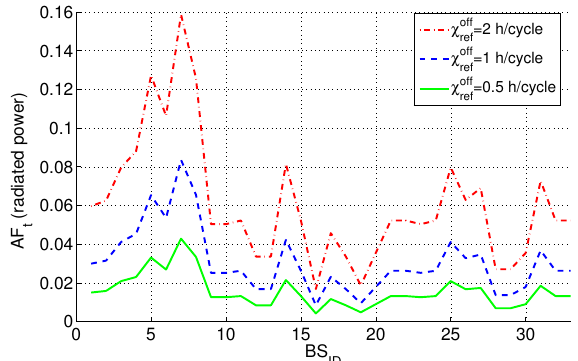
Figure 9. AF t (radiated power) with the exponential model.